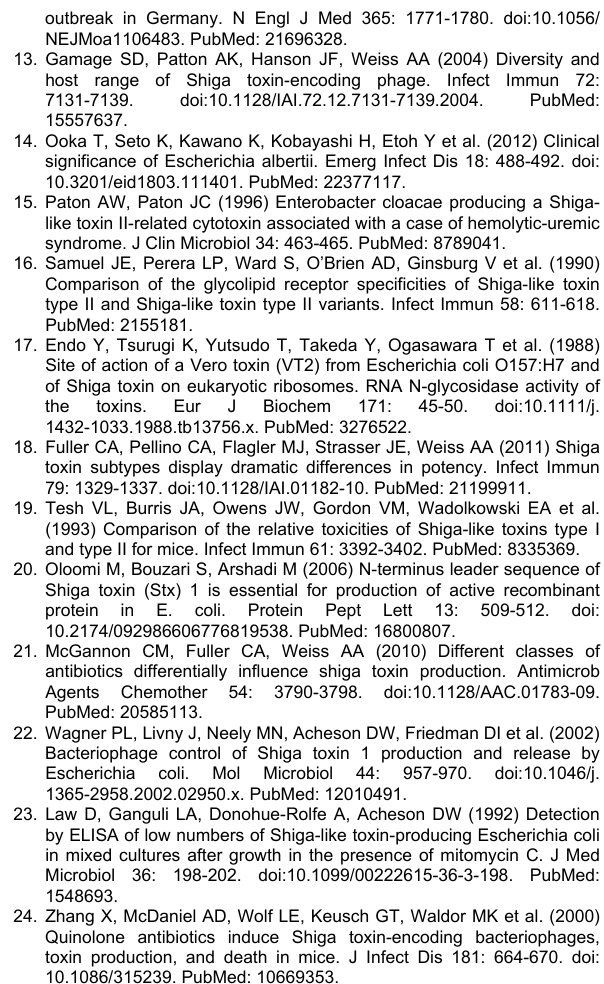
Figure S3. A. Stx2f colony immunoblot with Stx2f- and Stx2a- expressing strains, as well as GFP-labeled control cells. The same plate portion is displayed for all four panels. B. Confirmation of the presence of the stx2a and stx2f genes by colony PCR. The Stx2a-specific PCR band is ~347 base pairs; the Stx2f-specific band is 424 base pairs. All colonies that are neither green (GFP) nor red (Stx2f-producing) are Stx2a- producing, confirmed by colony PCR (colony no. 1, 4, 7, 9, 12, and 14).